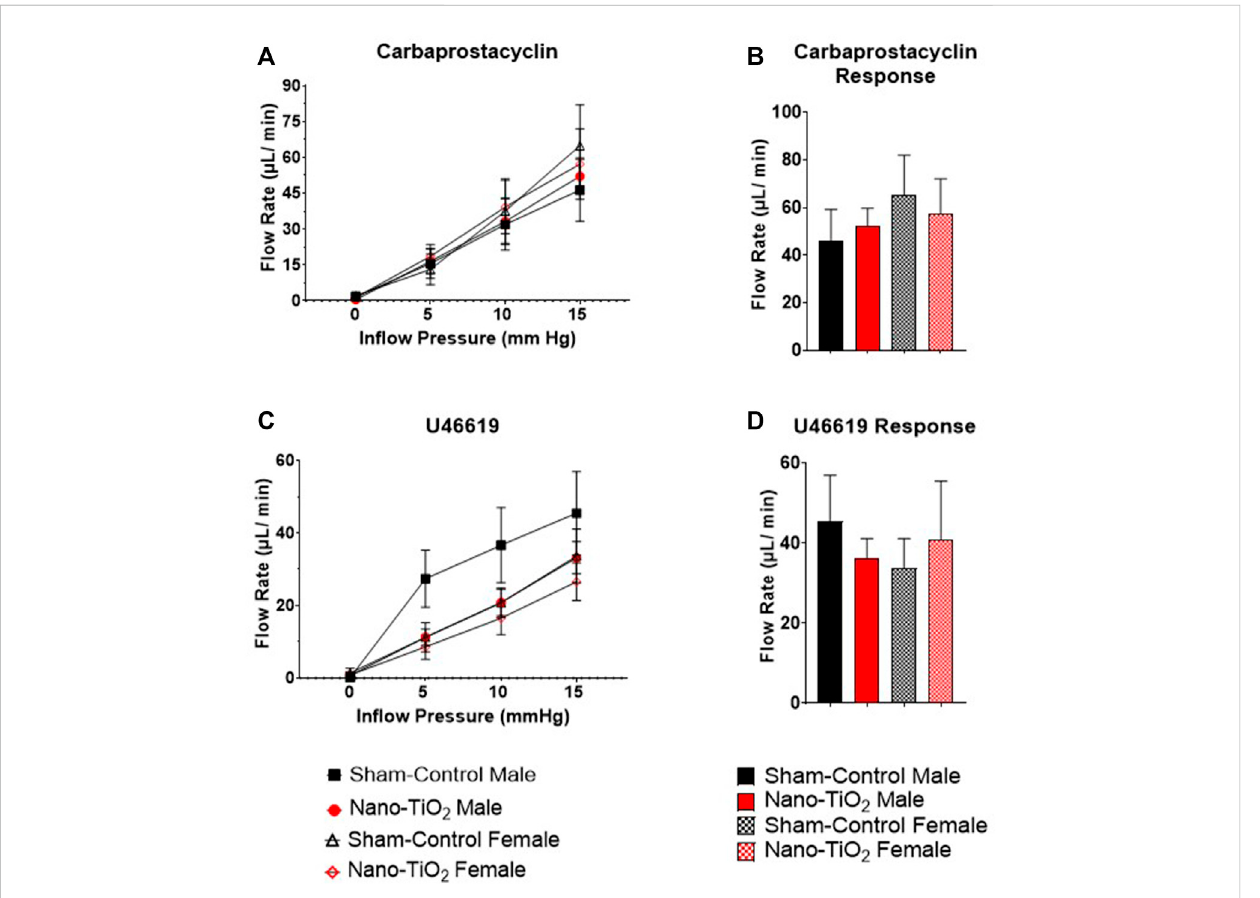
Placental Cyclooxygenase Metabolites fl ow rate hemodynamics. Flow rate was calculated and recorded during in fl ow pressure increases in a stepwise manner. (A) Placenta fl ow rate in the presence of carbaprostacyclin, a stable PGI 2 agonist, across increased in fl ow pressure. (B) Maximum fl